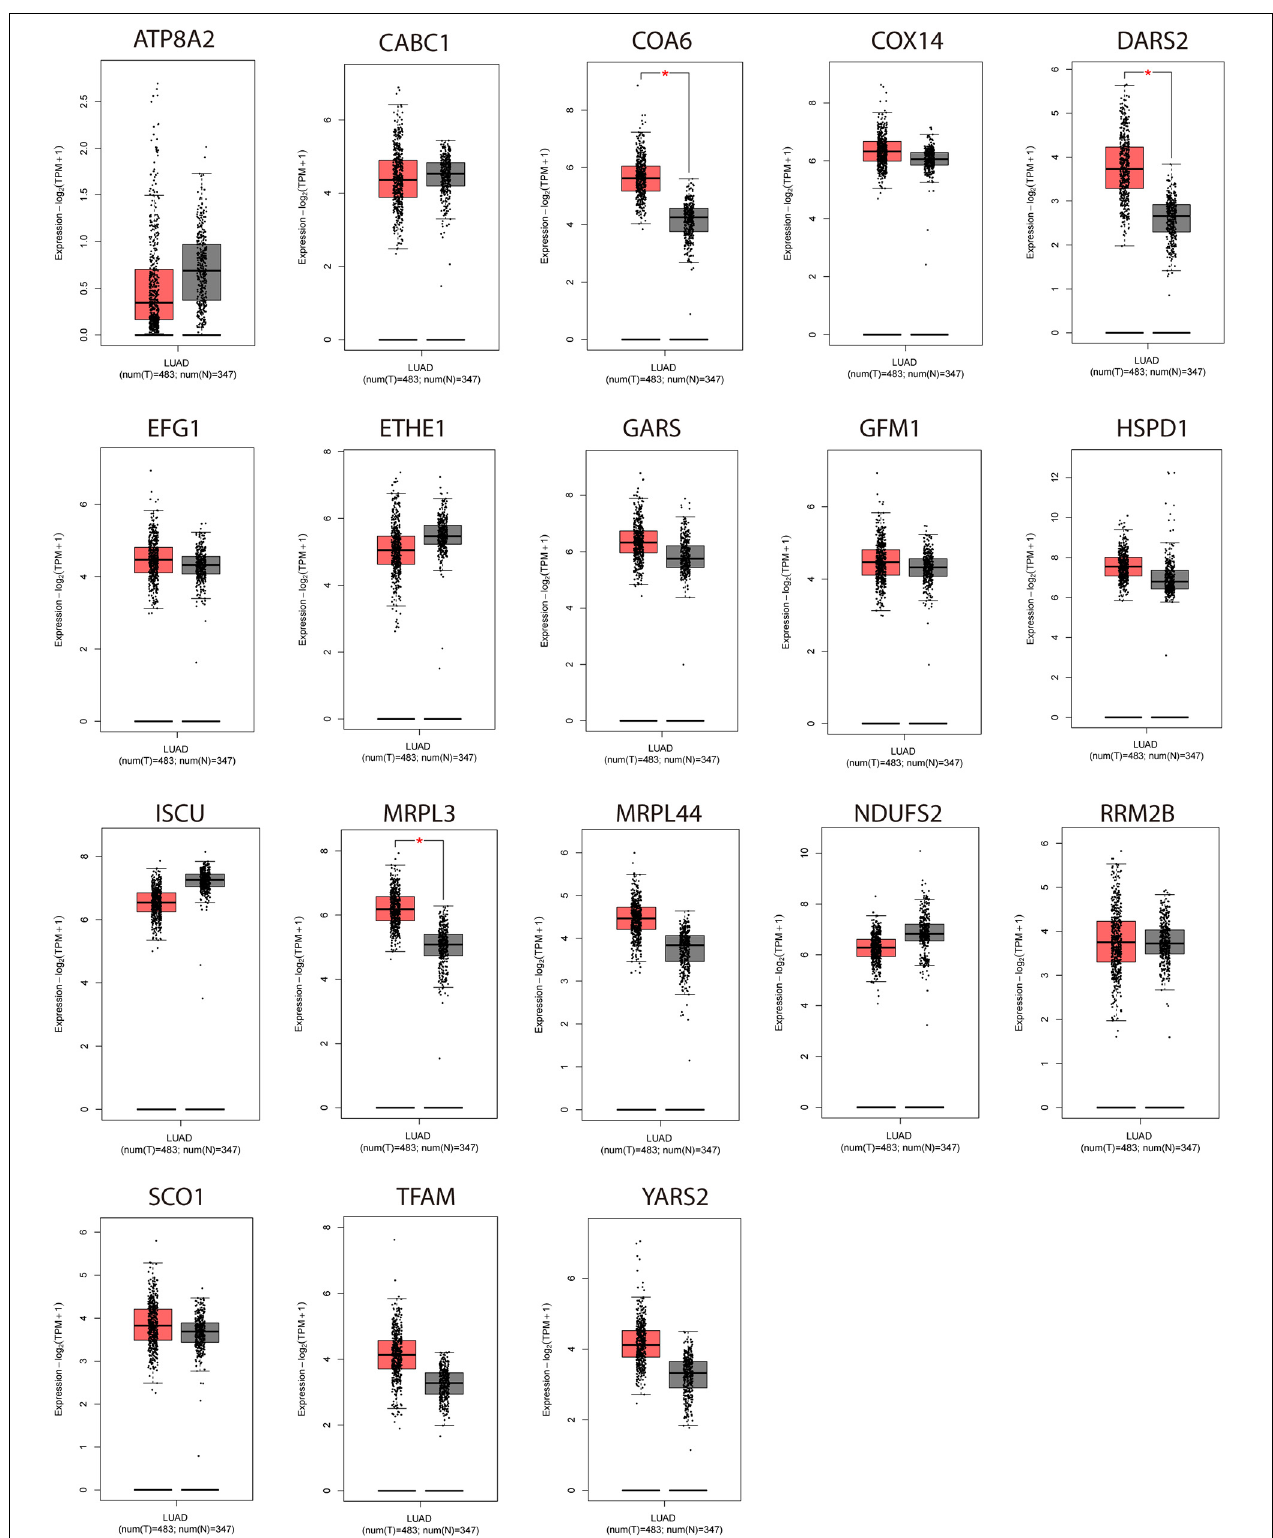
FIGURE 2 | Expression analyses of the 18 genes ( NDUFS2, ATP8A2, SCO1, COX14, COA6, RRM2B, TFAM, DARS2, GARS, YARS2, EFG1, GFM1, MRPL3, MRPL44, ISCU, CABC1, HSPD1, ETHE1 ) in LUAD samples and normal samples. * P < 0.05.